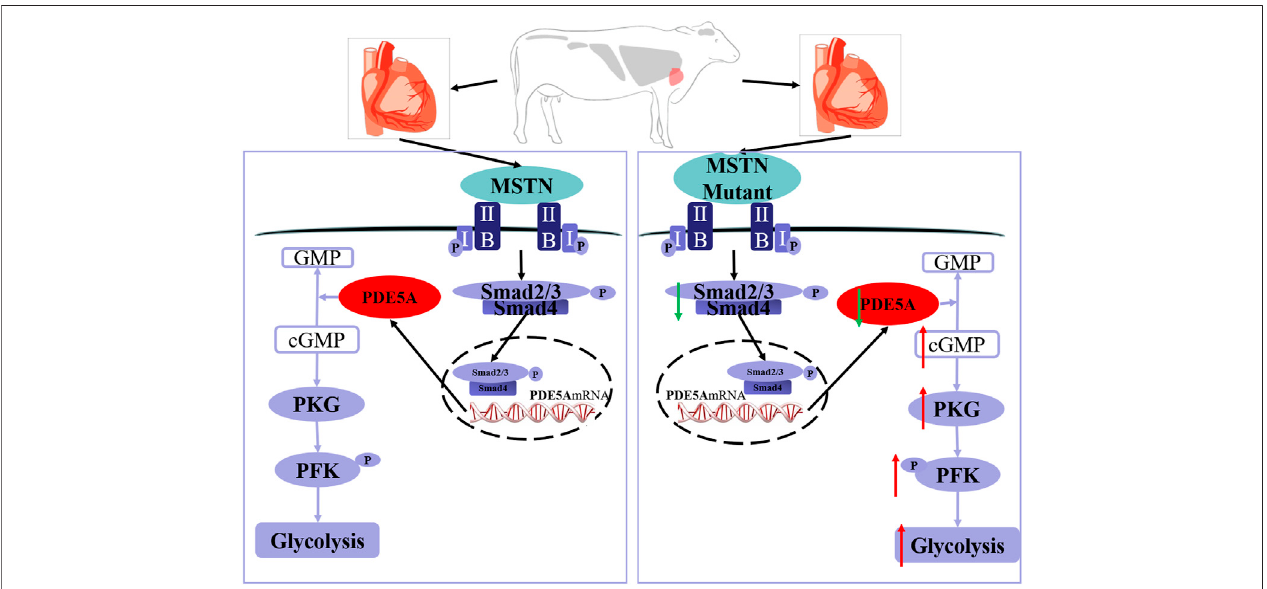
FIGURE7| SchematicofmechanismsfortheactivationofPDE5A-cGMP-PKGsignalingandthepromotionofglycolysisbyMSTN.MSTNactivatethepathway via combining with ActRIIB, which then binds to the type I receptor to form a receptor complex. After the receptor complex is activated by the signal, SMAD2/SMAD3 is activated via phosphorylation. Then, SMAD2/SMAD3 will detach from receptor complex and bind to SMAD4. Then, the heteromeric complex enters the nucleus, binds to the promoter region, and alters transcription of PDE5A gene. The left one is the wild-type cattle and the right one is the MSTN mutant cattle. The MSTN mutant decreased SMAD2/3 expression, which led to transcription downregulation of PDE5A and thereby promoted the cGMP/PKG pathway, increased the phosphorylation level of PFK, and subsequently enhanced glycolysis. The red arrow indicates upregulation and the green arrow indicates downregulation.